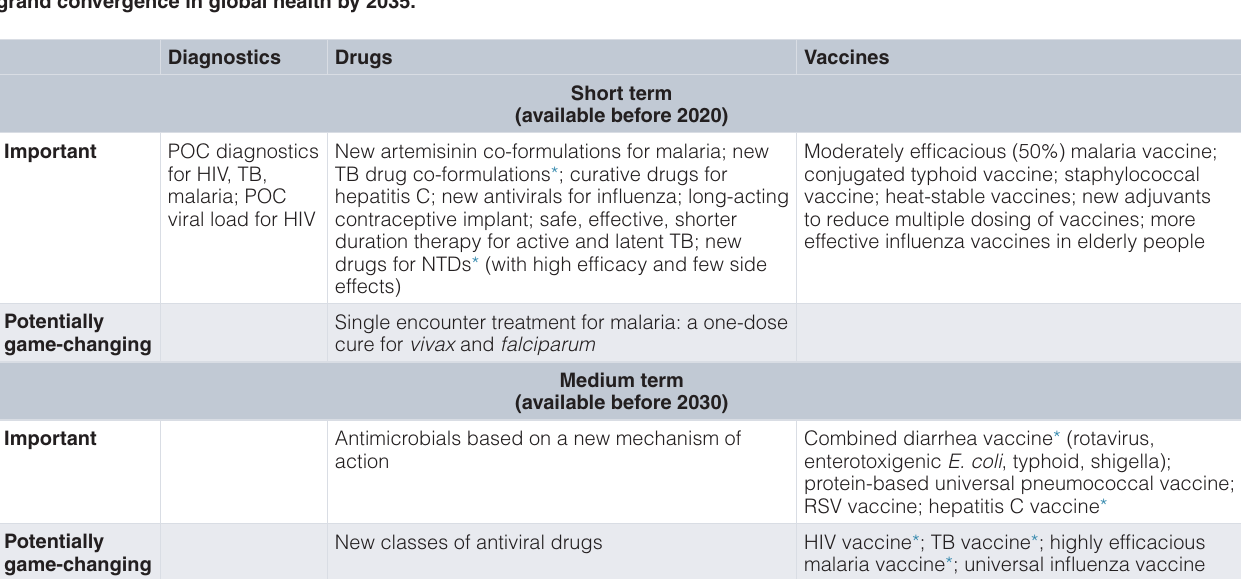
Table 5. Important or game changing products proposed by the Commission on Investing in Health that could help achieve a grand convergence in global health by